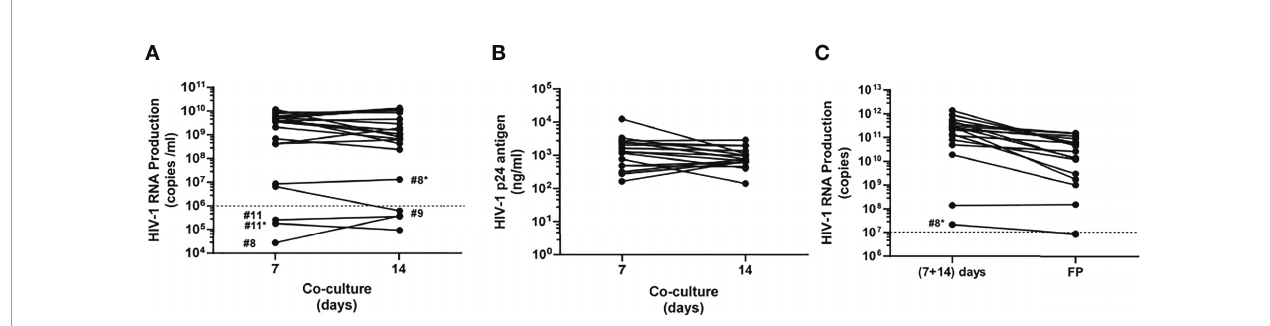
FIGURE 3 | Monitoring autologous HIV-1 production. (A) Viral load titrated at 7 and 14 coculture days as HIV-1 RNA copies/ml in raw harvested supernatants. Dashed line shows the cutoff value according to the Investigational Medicinal Product Dossier (IMPD), meaning 10 6 HIV-1 RNA copies/ml. (B) HIV-1 p24 ng antigen/ ml at 7 and 14 coculture days was only determined for those supernatants exceeding 10 6 HIV RNA copies/ml. (C) HIV-1 RNA copies/ml in mixed supernatants (7 + 14 coculture day harvests) versus fi nal products (FPs). Dashed line shows 10 7 HIV-1 RNA copies/ml as cutoff value to release immunogens, according to the